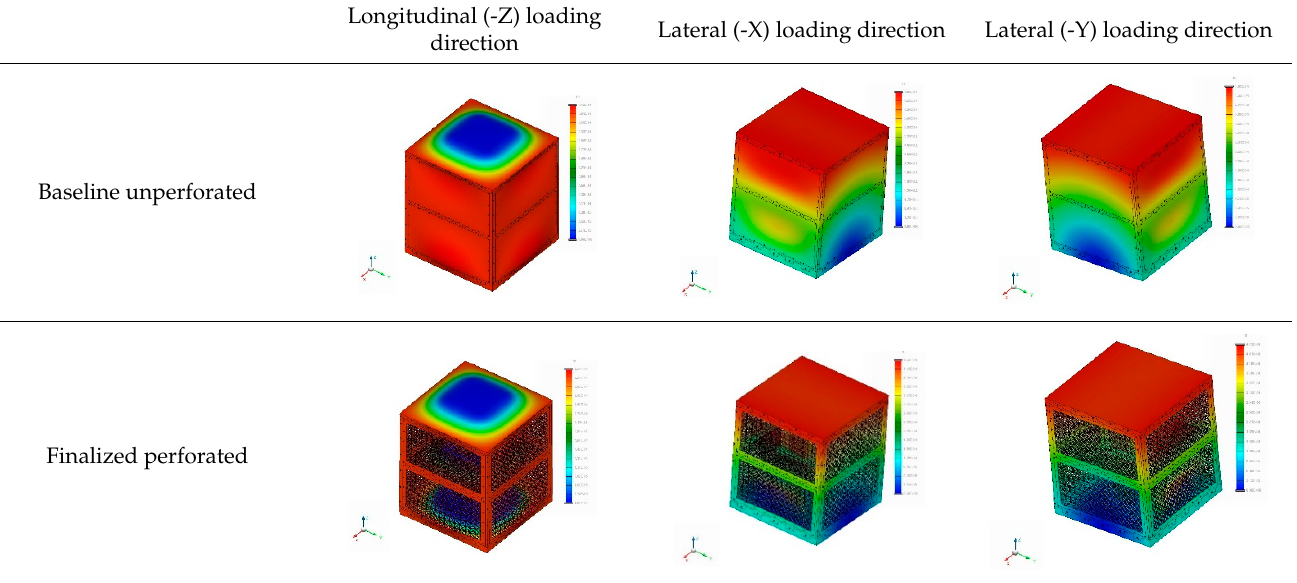
Table 9. Maximum displacements from quasi-static launch loadings.